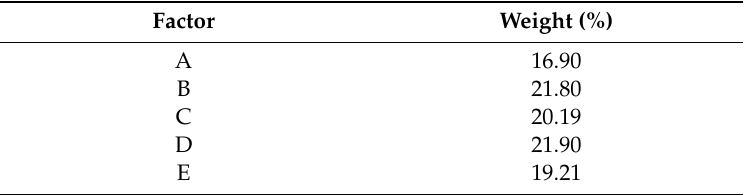
Table 5. The relative weight of five factors and extraction